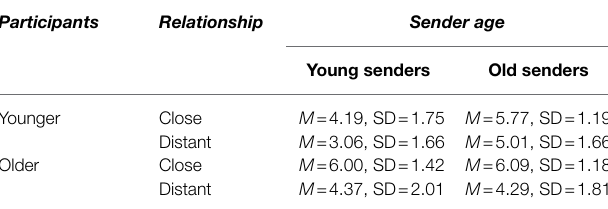
TABLE 5 | The mean score and standard deviation of friendliness in Experiment